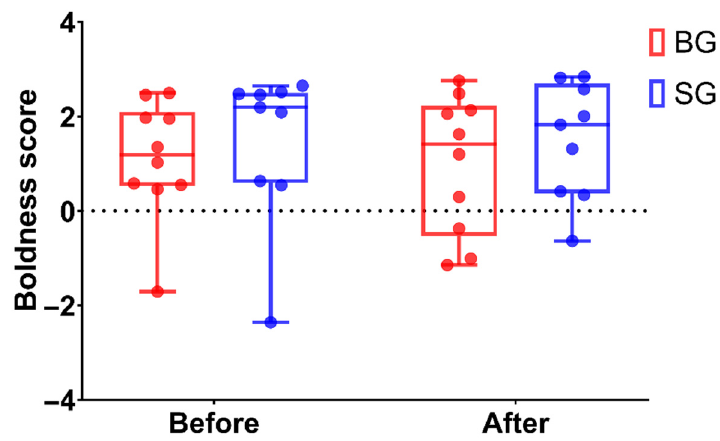
Figure 3. The boldness score of Mongolian gerbils before and after gut microbiota transplantation. Data are means ± SEM. (BG: “bold fecal” gavage group, SG: “shy fecal” gavage